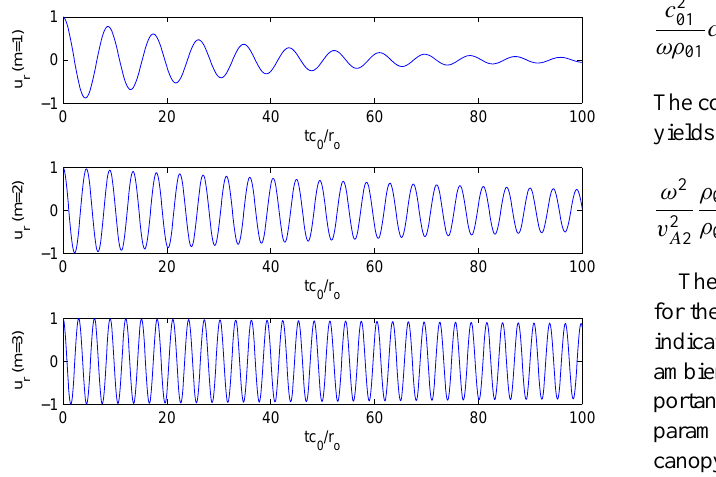
Fig. 2. Temporal dynamics of velocity perturbations in the field-free cavity areas for m = 1 , 2 , 3